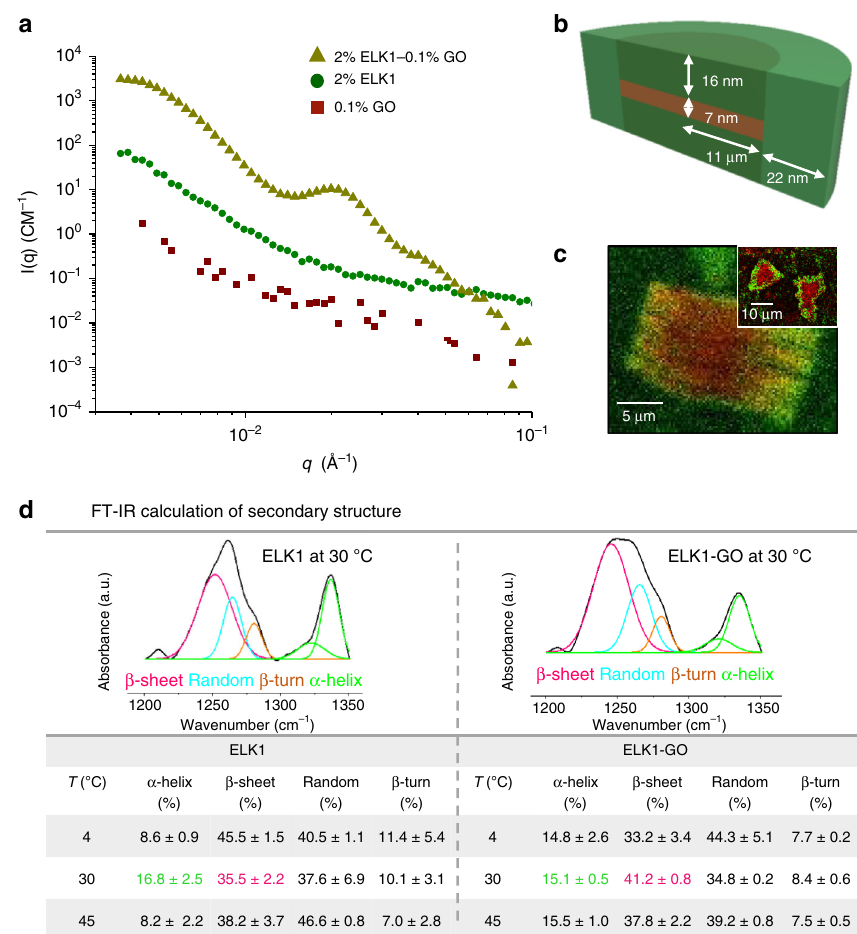
Fig. 4 Supramolecular assembly of the ELK1 – GO system. a Small-angle neutron scattering (SANS) patterns demonstrating a resulting uniform microstructure formed when co-assembling ELK1 – GO. Between the middle- q region (ca 0.007 – 0.04 Å − 1 ), the ELK1 – GO structure (yellow triangle) exhibits a characteristic scattering peak associated with pure ELK1 (green square) and GO (red circle) at 30 °C, con fi rming the formation of a new order structure different from the individual components. b The classical core – shell – bicelle – elliptical model that was fi tted to the ELK1 – GO microstructure as measured by SANS at 30 °C (green: ELK1, brown: GO). c Confocal microscopy (green: ELK1, red: GO) corroborating the interaction between the ELK1 and the GO lamellae (inset depicts the top view of the ELK1 – GO structure). d FT-IR calculation of secondary structure depicting the change and transition of conformation of the ELK1 molecule before and after binding with GO. At 30 °C and before binding with GO, ELK1 exhibits higher α -helix than at 4 and 45 °C, which is maintained after binding with GO and is complemented with an increase in β